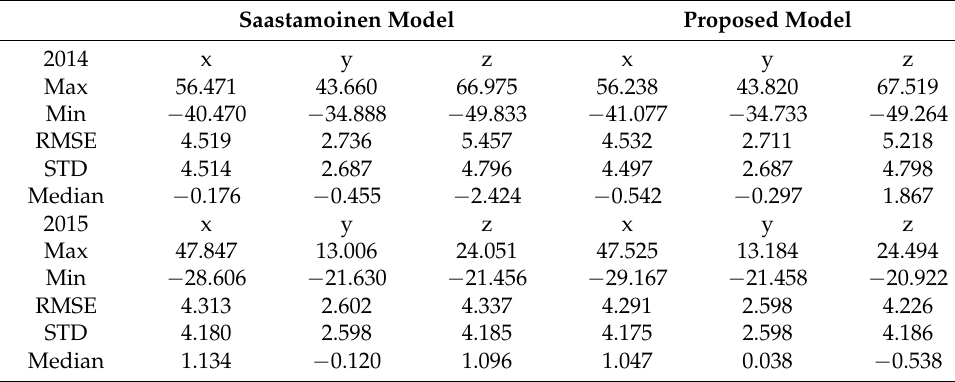
Table 8. Comparison of the realized values of RMSE, STD, range, and medians for the Dubrovnik GNNSS position obtained using the Saastamoinen model and the proposed model (in